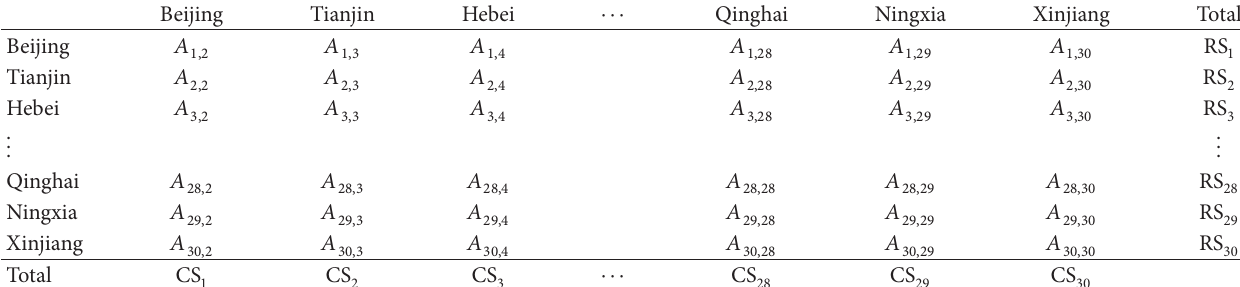
Table 1: The interprovincial trade matrix of a good